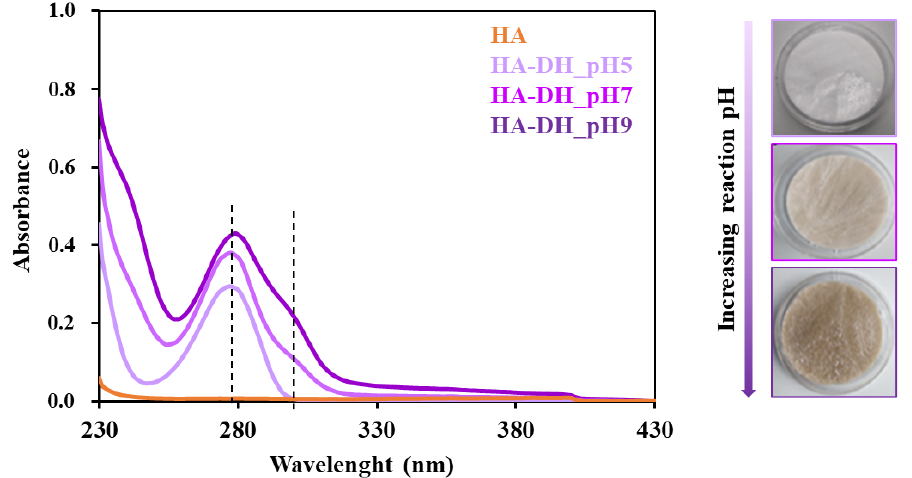
Figure 3. UV-vis profiles of HA (orange), HA-DH_pH5 (light violet), HA-DH_pH7 (violet) and HA-DH_pH9 (dark violet) acquired in the 230–430 nm spectral range. Dashed lines identify the peak at 280 nm exploited for DH quantification and the shoulder at 310 nm attributed to DH molecules in their oxidized form. Representative images of lyophilized HA-DH_pH5, HA-DH_pH7 and HA-DH_pH9 (from top to bottom) showing a progressively increasing brownish color.